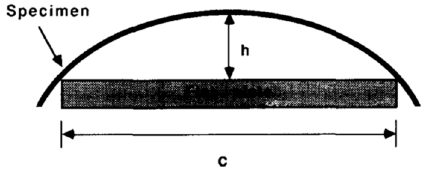
Figure 1. Curvature in cylindrical composite strip due to non-symmetric layup [32].